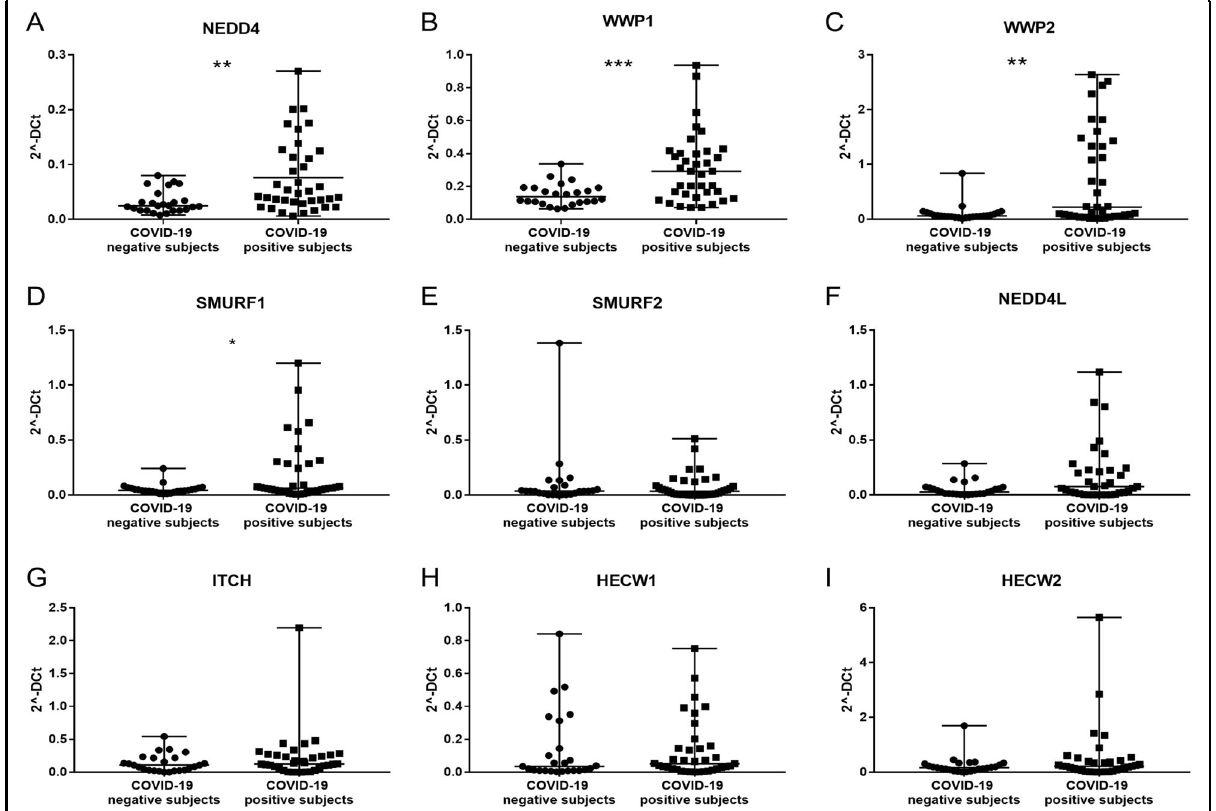
Fig. 2 HECT E3 ubiquitin ligase gene expression level in SARS-CoV-2 positive and negative groups of subjects. A NEDD4 expression level in SARS-CoV-2 positive and negative groups of subjects, Mann – Whitney test, exact p value p = 0.0016, **; B WWP1 expression level in SARS-CoV-2 positive and negative groups of subjects, Mann – Whitney test, exact p value p = 0.0005, ***; C WWP2 expression level in SARS-CoV-2 positive and negative groups of subjects, Mann – Whitney test, exact p value p = 0.0038, **; D SMURF1 expression level in SARS-CoV-2 positive and negative